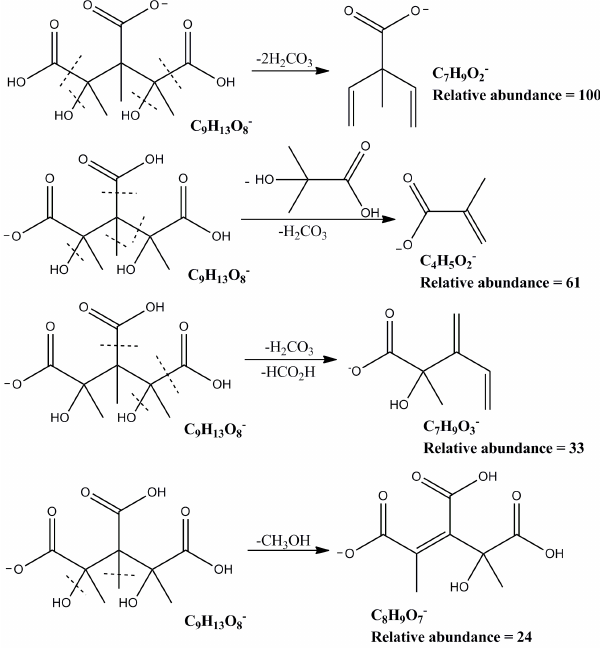
q K) and C 6 H 9 O − from 6